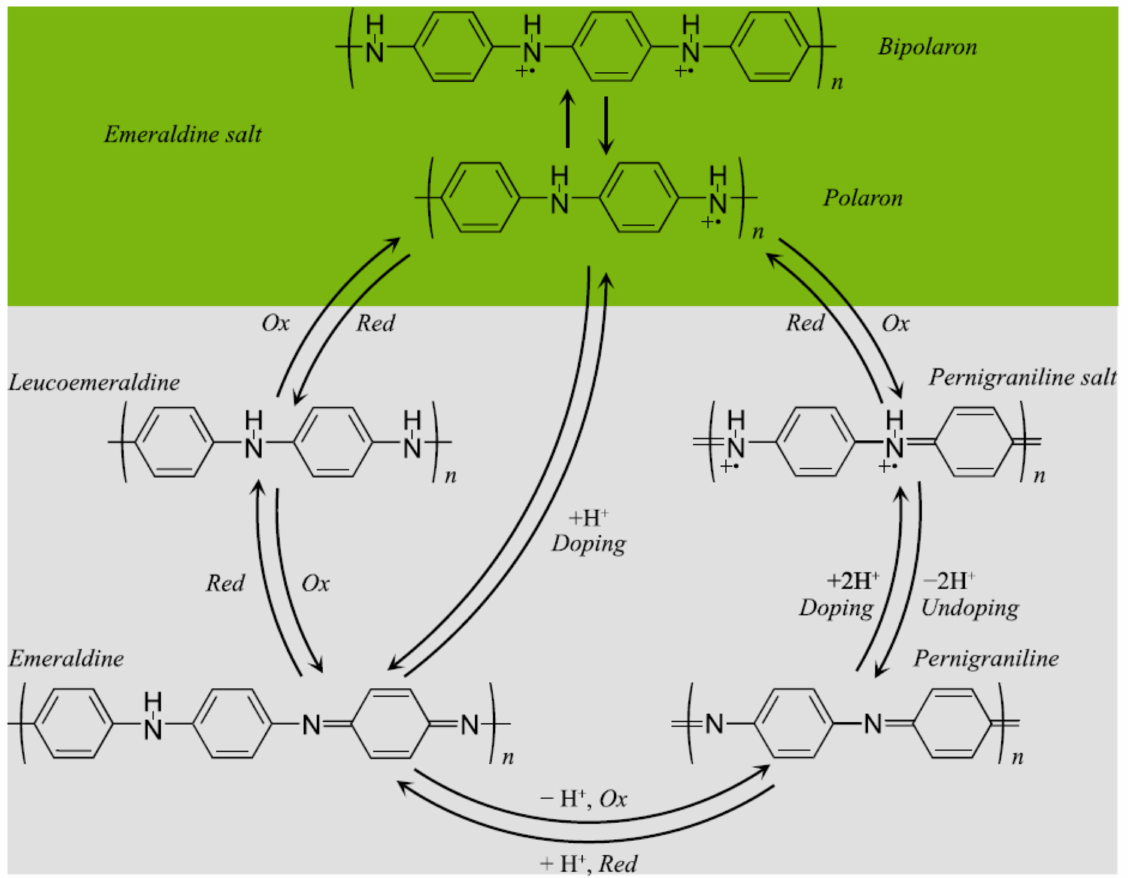
Figure 6. Basic polyaniline structures: Leucoemeraldine, Emeraldine salt, and